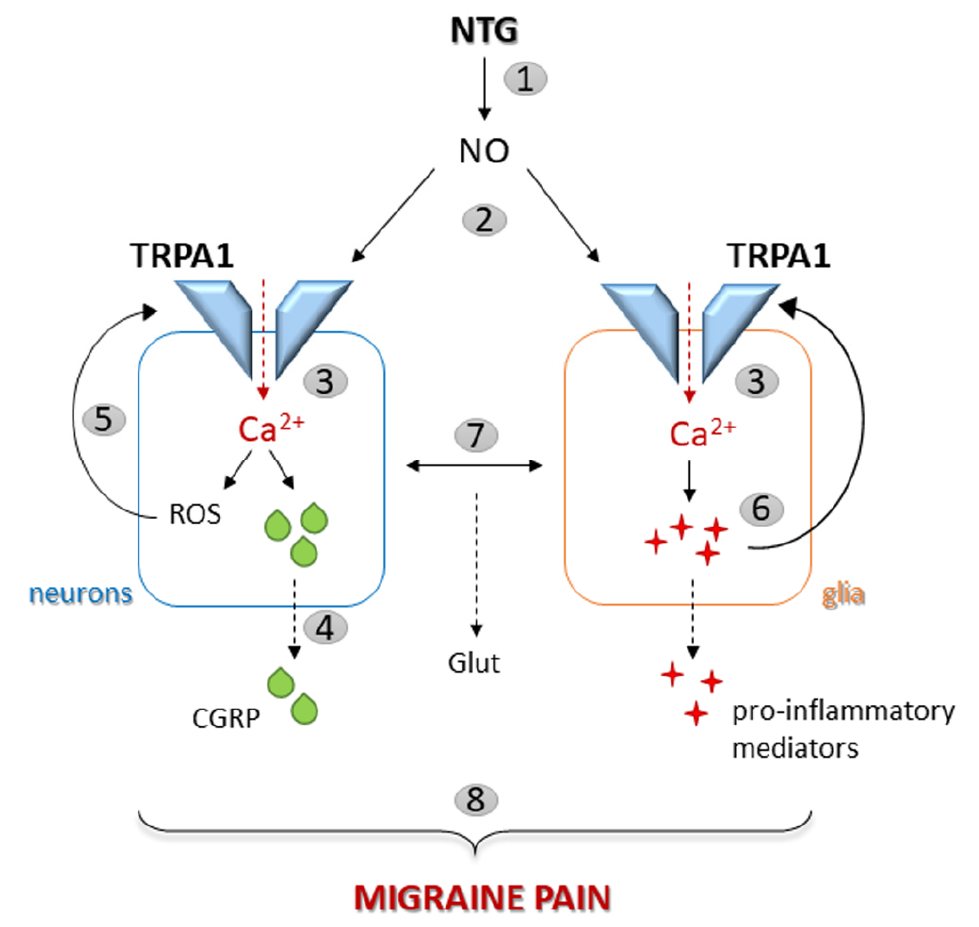
Figure 8. Schematic representation of the putative TRPA1-mediated mechanisms involved in migraine pain. The administration of NTG promotes the formation of nitric oxide (NO) (1) which directly activates TRPA1 channels (2). Once activated, these channels allow the intracellular concentration of calcium to increase (3). At the neuronal level, TRPA1 activation promotes the release of CGRP (4) and the generation of reactive oxygen species (ROS), which can sensitize the TRPA1 channels (5). In glial cells, following TRPA1 activation and calcium entrance (3), the expression of glial markers and pro-inflammatory molecules (sensitizing TRPA1 channels) increases (6) and neuron–glia coupling promotes glutamatergic signaling (Glut) (7). All of these processes contribute to the generation and maintenance of migraine pain